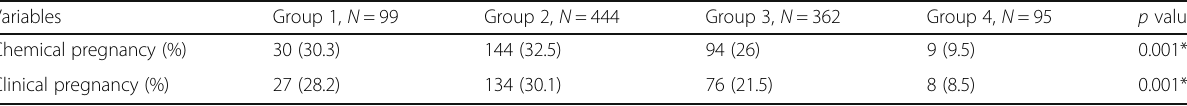
Table 3 The rate of pregnancy between different age groups Variables